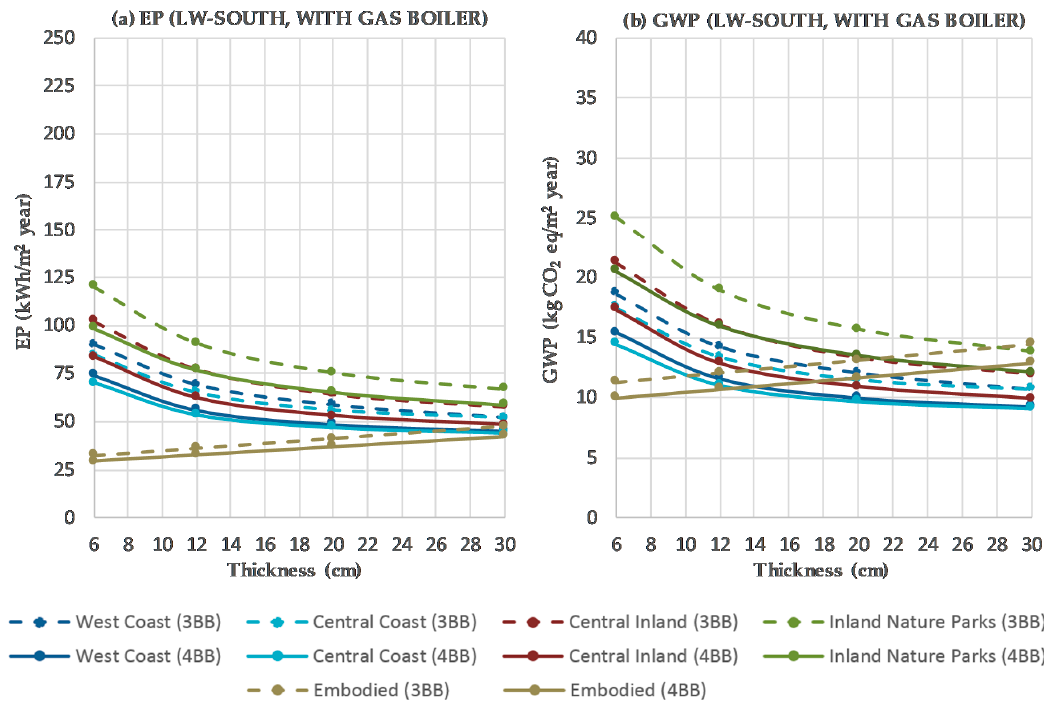
Figure 10. Embodied and use impacts of primary energy and CO 2 equivalent emissions for the natural gas boiler scenario, depending on insulation thickness, for the four locations, with LW-SOUTH both for 4BB and 3BB.